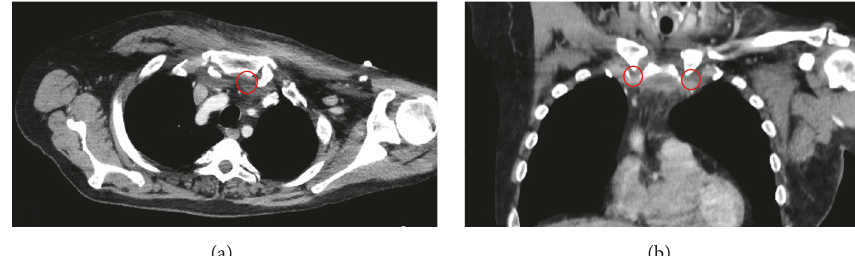
Figure 2: Chest CT scans. (a) Axial image; (b) coronal image showing evidence of bilateral sternocleidomastoid inflammation/infection. Thickened soft tissue was noted surrounding the SC joints and posterior to the sternum labelled by the red